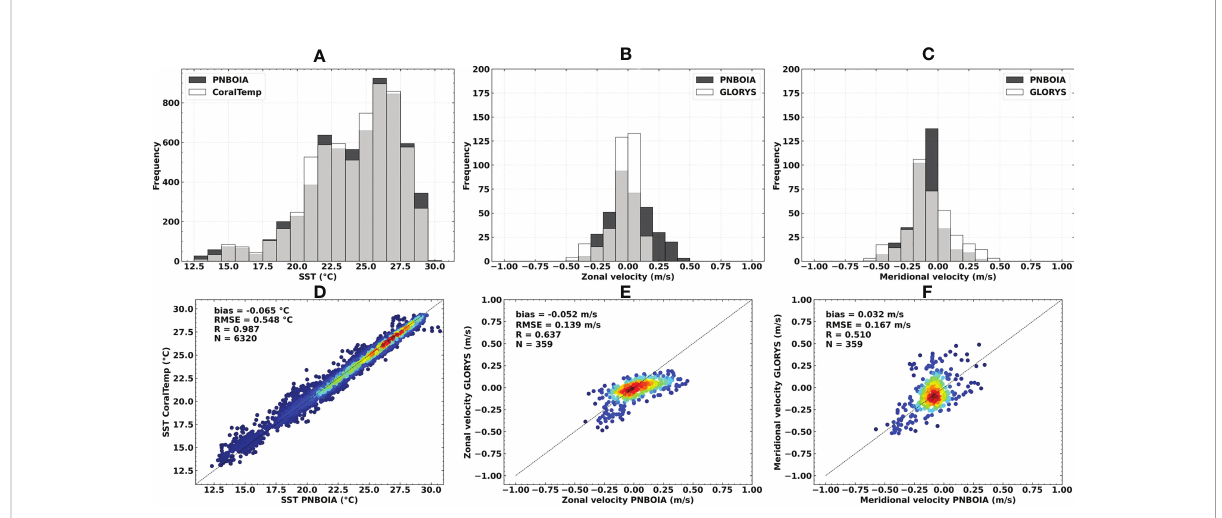
FIGURE 3 Sea surface temperature, zonal and meridional surface current velocities statistical comparisons in relation to in situ PNBOIA measurements: (A, D) CoralTemp SST (°C); (B, E) GLORYS12V1 ocean currents zonal velocity (m/s); (C, F) GLORYS12V1 ocean currents meridional velocity (m/s). N = number of observations. Warmer colors indicate higher data